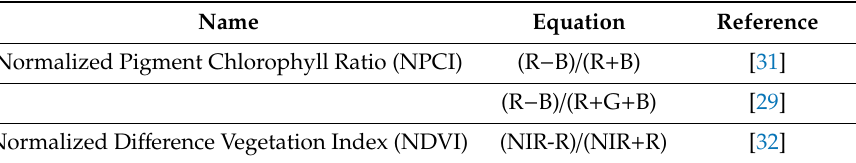
Table 1. Vegetation indices evaluated in this